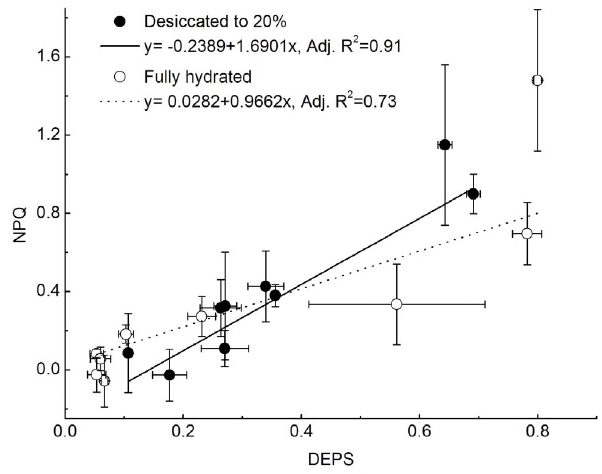
Figure 3. Responses of fully hydrated and emersed U.pertusa thalli to varying light intensities. For each light intensity tested, thalli of U. pertusa were emersed in air to desiccate to a water content of 20% or immersed in seawater (100%). Treatment times of desiccated and hydrated thalli were comparable. Error bars represent SD for n=3.